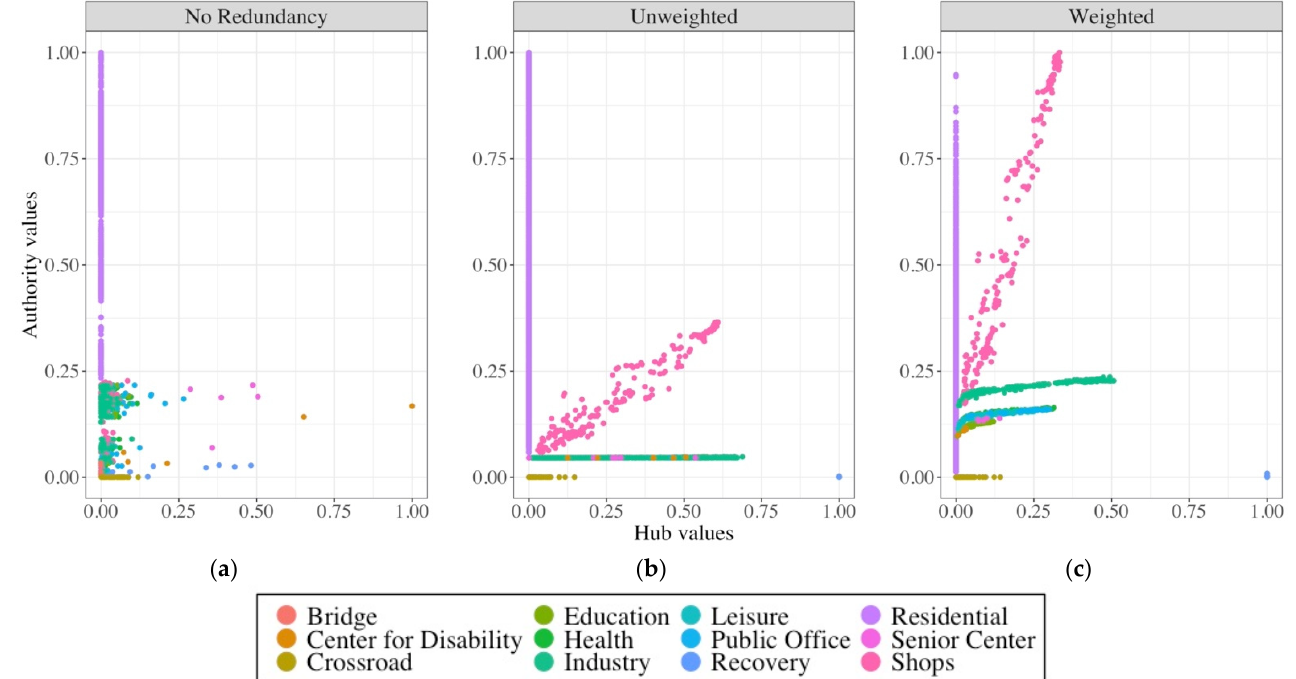
Figure 6. Plot authority versus hub for the three different graph configurations: ( a ) no redundancy; ( b ) redundancy unweighted, and ( c ) redundancy weighted.